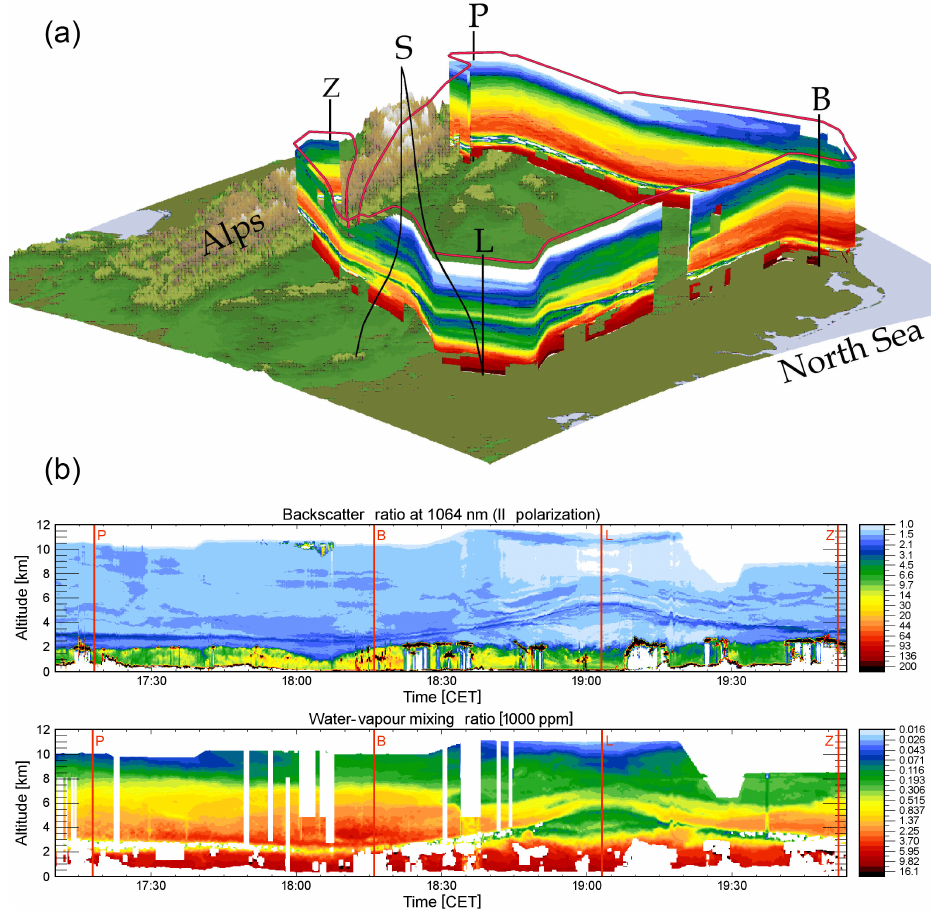
Figure 2. (a) Slant view from the north-east of the WALES flight in the late afternoon of 17 October 2008: P means Payerne (Switzerland), B Bilthoven (the Netherlands), L Lindenberg (north-eastern Germany), and Z Zugspitze (Garmisch-Partenkirchen, southern Germany). The flight track (red line) is shown above the “curtain” of the water-vapour profiles from the airborne DIAL measurements. The track of the Lindenberg sonde (S) is marked by a black line. (b) Vertical distributions of water vapour (bottom) and 1064nm aerosol backscatter ratio (top) along the flight track; the times of the overflights of the four stations are marked by red vertical